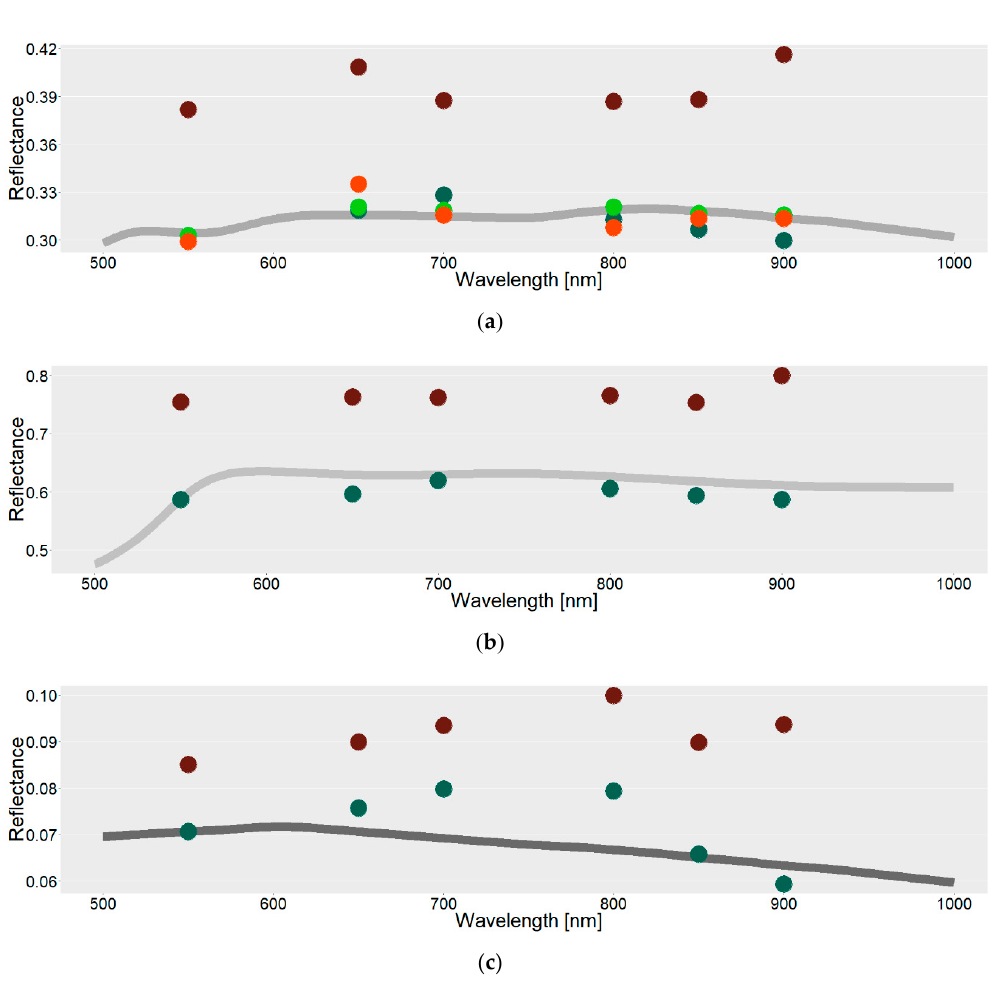
Figure 20. The location effect of calibration targets on radiometric corrections at validation target Light Grey 5 ( a ): The reflectance values are extracted from raw (red dots) and corrected (green dots) image using calibration targets 1 and 9, placed in the center. The reflectance values are extracted from raw (dark red dots) and corrected (dark green dots) image using calibration targets 4 and 7, placed near the outer edge of calibration images; The comparison of validation targets reflectance curves: ( b ) Cream 1; ( c ) Anthracite 9 (see Figure 5) derived from a spectrometer measurement with the median reflectance values of the same targets extracted from raw (dark red dots) and corrected (dark green dots) image.